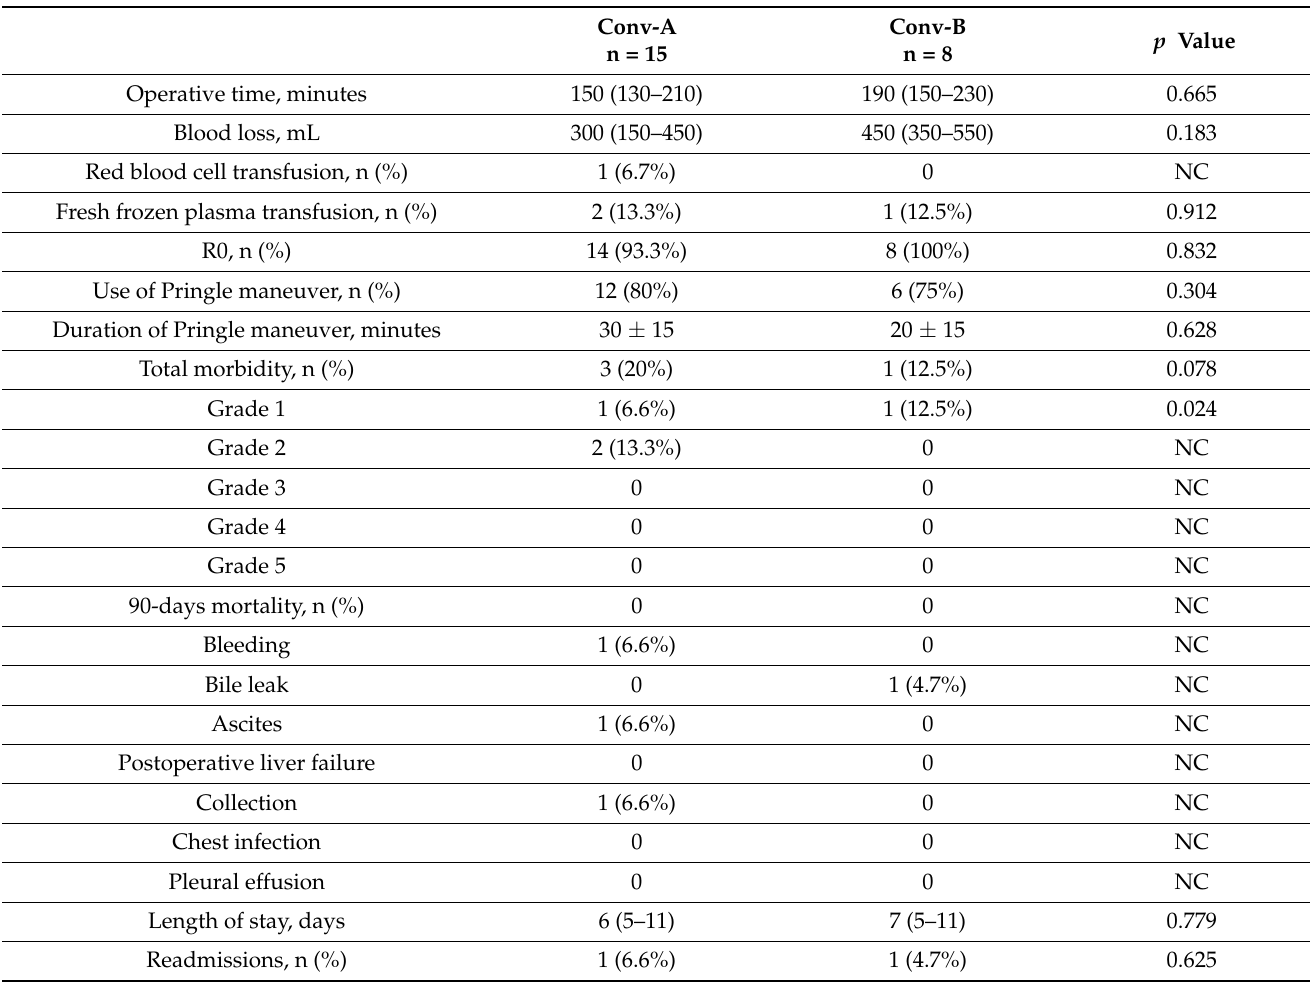
Table 6. Results of converted MILRs for HCC: Child A versus converted MILRs in advanced cirrhosis (Child B and Child A/B with portal hypertension) patients for low Iwate difficulty level